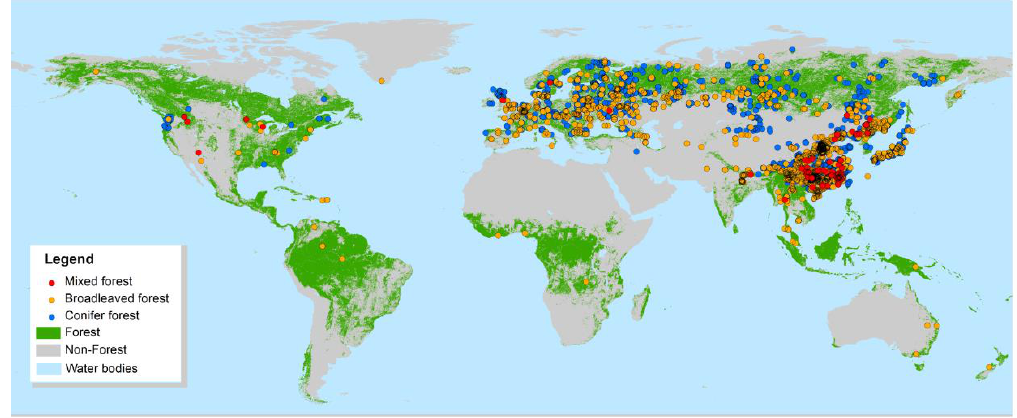
Figure 3. Spatial distribution of all plots measured across the world [50,51].